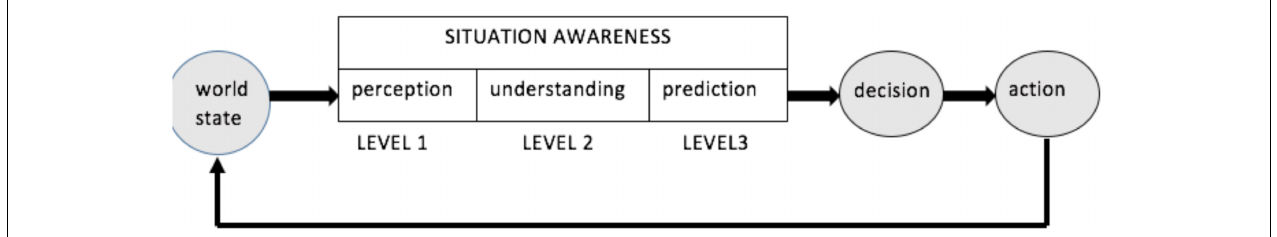
FIGURE 1 | Three levels of Situation Awareness (adopted from Endsley and Connors,